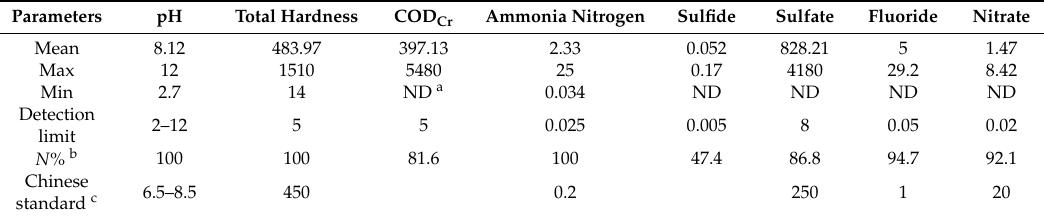
Table 2. Physicochemical indexes in groundwater samples ( N = 38) from the brownfield